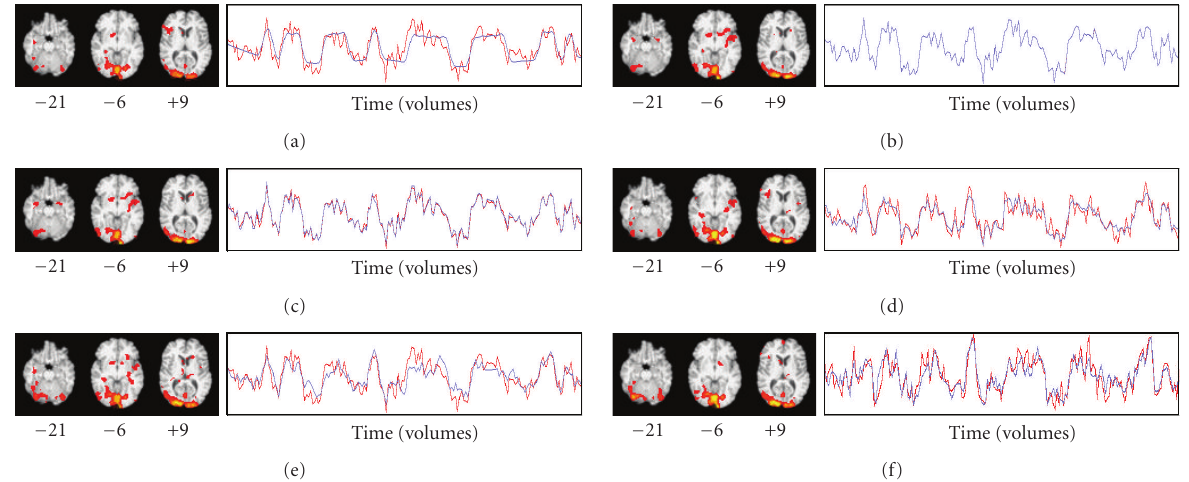
Figure 5: Spatial maps and time courses for Run 4: (a) task-related GLM; hybrid ICA-seed-based approaches, using the average time course from (b) a single voxel, (c) a few voxels, or (d) many voxels; and dual regression using seed spatial information from (e) an IC spatial map